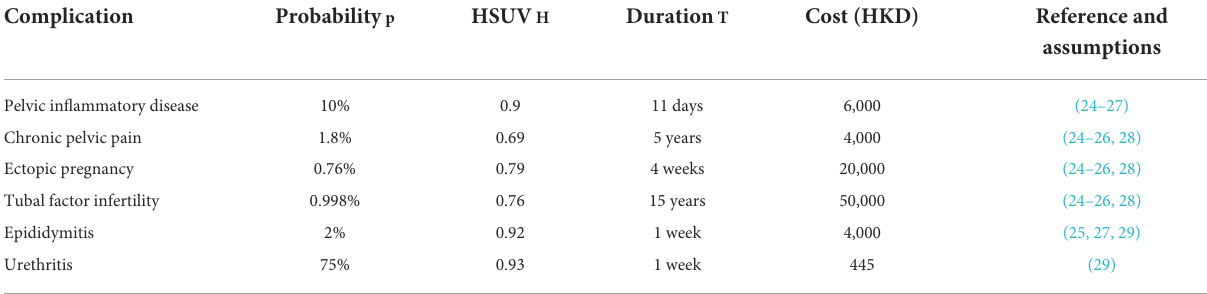
TABLE 4 Follow-on complication parameters: probability of occurrence (per untreated chlamydia infection), health state utility value (HSUV), duration and direct financial